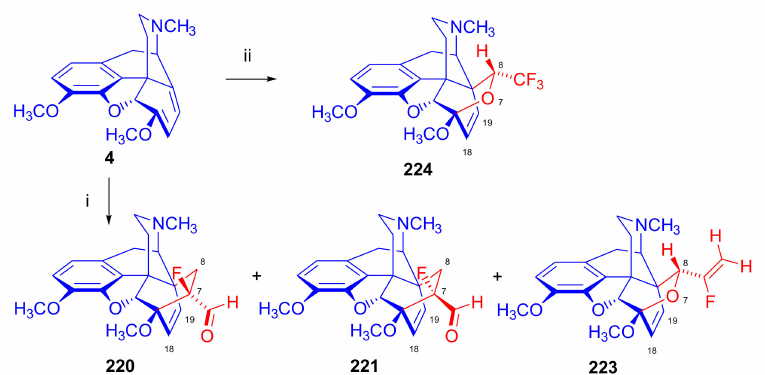
Figure 60. Reaction of thebaine with fluorine containing dienophiles. Reagents and conditions : (i): 2 equiv. 2-fluoroacrolein, benzene, 50 ◦ C, 18 h; (ii): 10 equiv. trifluoroacetaldehyde, benzene, 50 ◦ C, 24